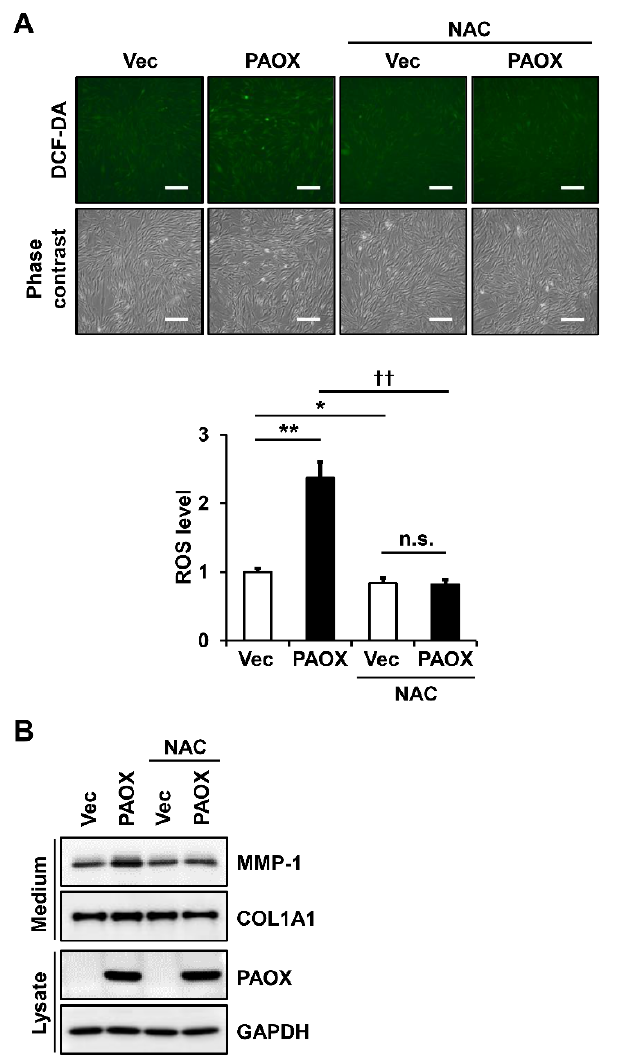
Figure 8. Effect of N -acetylcysteine (NAC) treatment on ROS generation and MMP-1 secretion in fibroblasts expressing PAOX. Fibroblasts infected with GFP-deleted vector viruses or GFP-deleted PAOX viruses were incubated in a serum-free and phenol-red-free DMEM for 24 h, with or without 5 mM NAC. ( A ) Intracellular ROS were detected by green fluorescence at 525 nm after staining with 10 µ M DCF-DA for 30 min. ROS levels were assessed using ImageJ software, normalized with cell numbers counted using crystal violet staining, and depicted on a graph relative to the ROS levels in untreated vector-infected cells. Each value represents the mean ± standard deviation of three independent experiments. * p < 0.05 and ** p < 0.01 vs. vector control. †† p < 0.01 vs. PAOX. n.s.: not significant. Magnification: × 100. Bar = 200 µ m. ( B ) Conditioned media and cell lysates were analyzed using Western blotting with anti-MMP-1, anti-pN-COL1A1, anti-PAOX, and anti- GAPDH